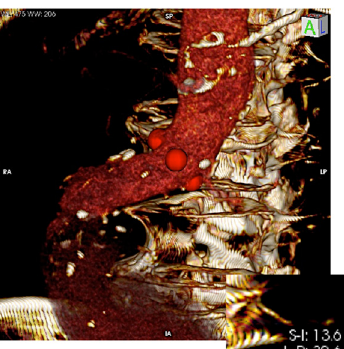
Fig. 3 - Three-dimensional tomographic reconstruction. Note that the points are equally spaced and aligned, allowing a view at the right angle of the renal artery studied (right). The viewing angles to be used in the correction of intraoperative fluoroscopy were provided by the software itself (below right, highlighted - in this case, craniocaudal 13,6 o and left-anterior-oblique - 30,6 o ). The values used for surgical arch are approximate